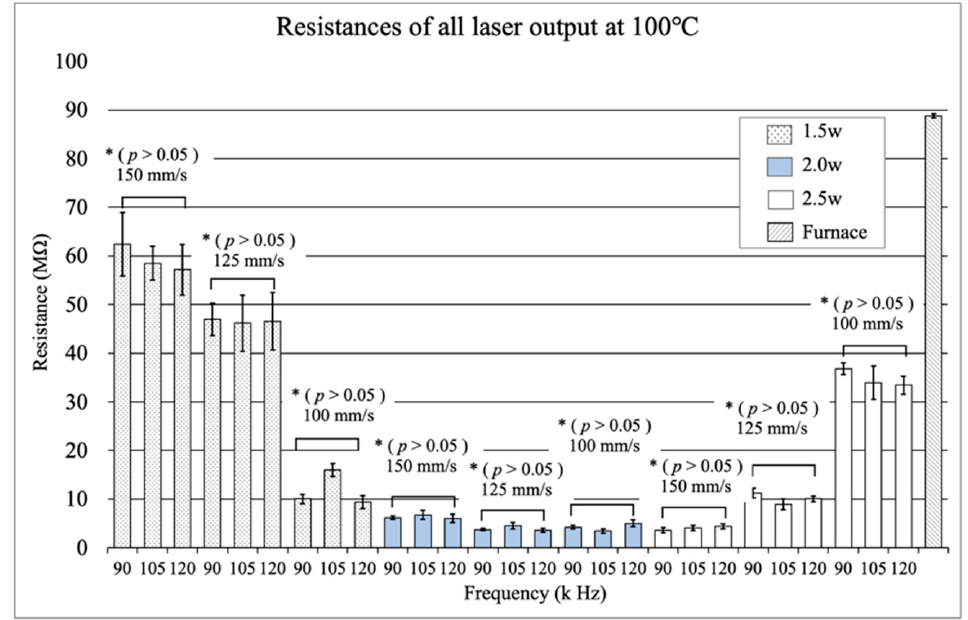
Figure 7. Resistance experimental results of all laser parameters that were measured at 100 ° C and compared with furnace calcination process (far right in each chart).